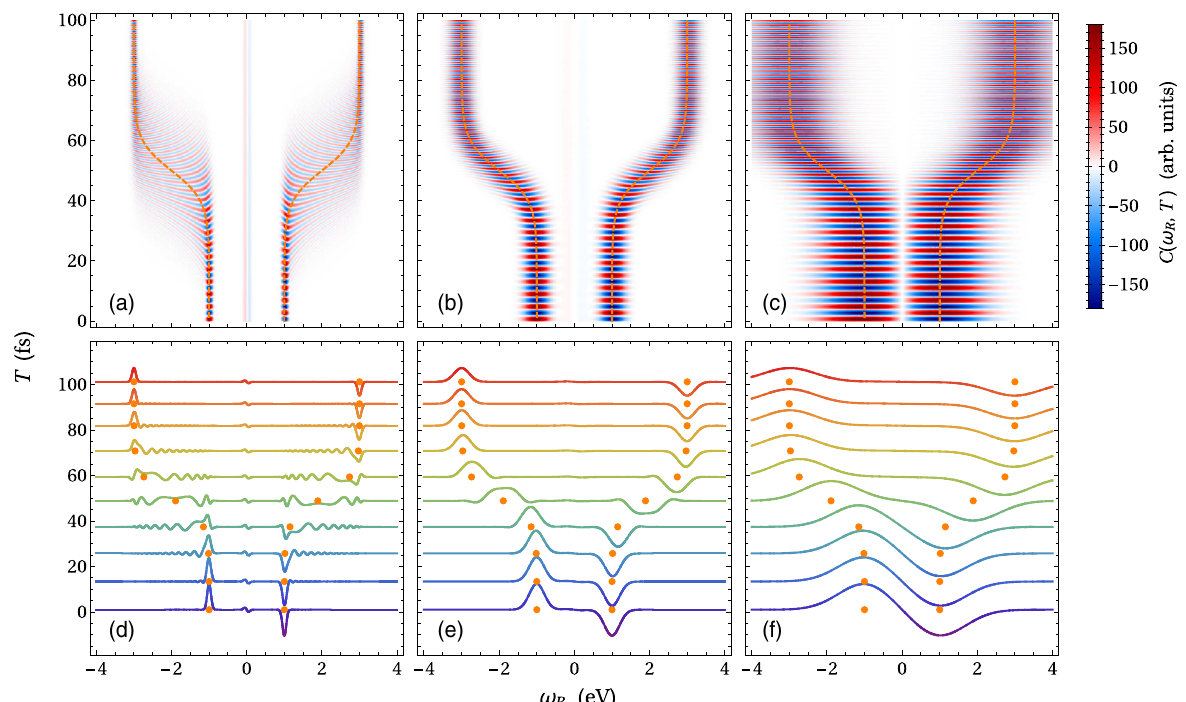
FIG. 9. STRUECARS signal for stochastic x-ray UDSP pulses with a < π . The correlation function in Eq. (37) is exhibited for σ ¼ 10 eV and(a),(d) τ ¼ 19 fs, (b),(e) τ ¼ 4 . 7 fs, and(c),(f) τ ¼ 1 . 3 fs. Thecorrelationfunctionisshown (a) – (c)asa functionofthe time delay T and the Raman frequency ω , and (d) – (f) for selected time delays. The orange dashed line in (a) – (c) and the orange dots in (d) – (f) R 0 t Þ in Eq. (18). The mean frequency ω < σ . Here, we set ω display the time-dependent frequency ω must be such that j ω ba ð m m j m ¼